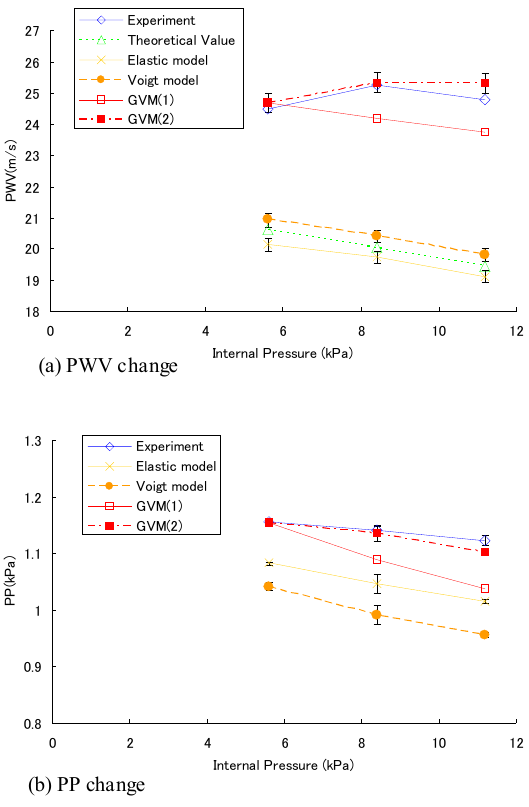
Fig. 10 PWV and PP change with internal pressure